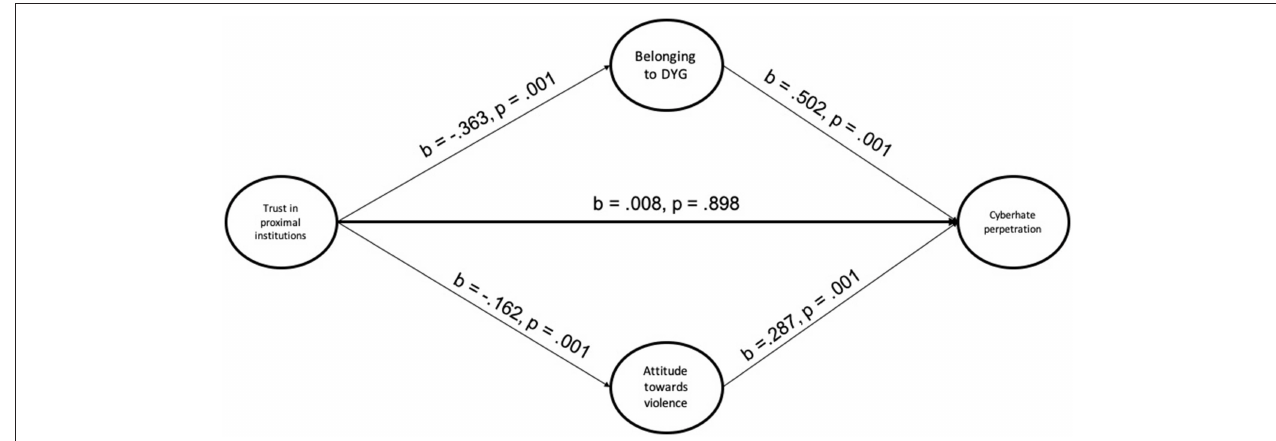
FIGURE 2 | Multiple mediation